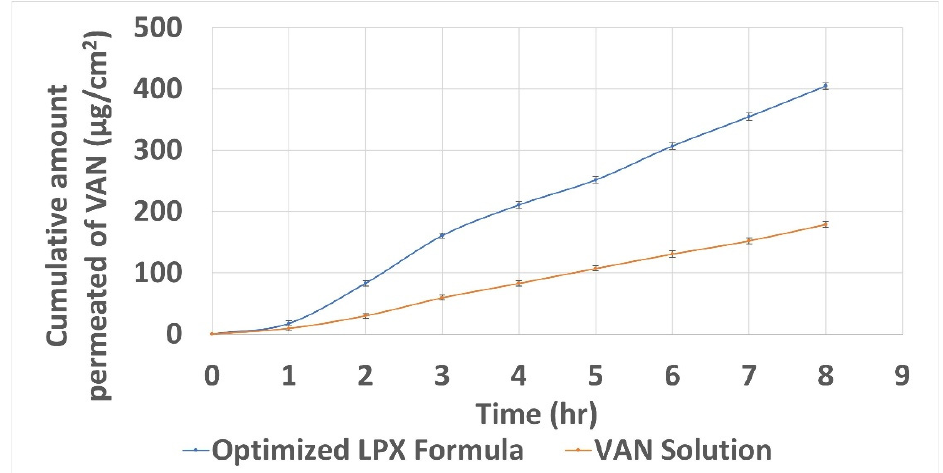
Figure 6. Cumulative amount permeated of VAN from the optimized LPX formula and aqueous solution. Abbreviations: VAN, Vancomycin hydrochloride; LPX, leciplex.